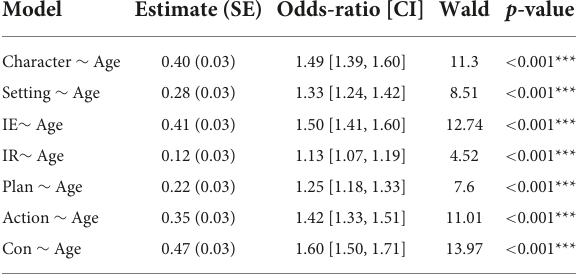
TABLE 3 Results of OLR for macrostructure element scores by age.